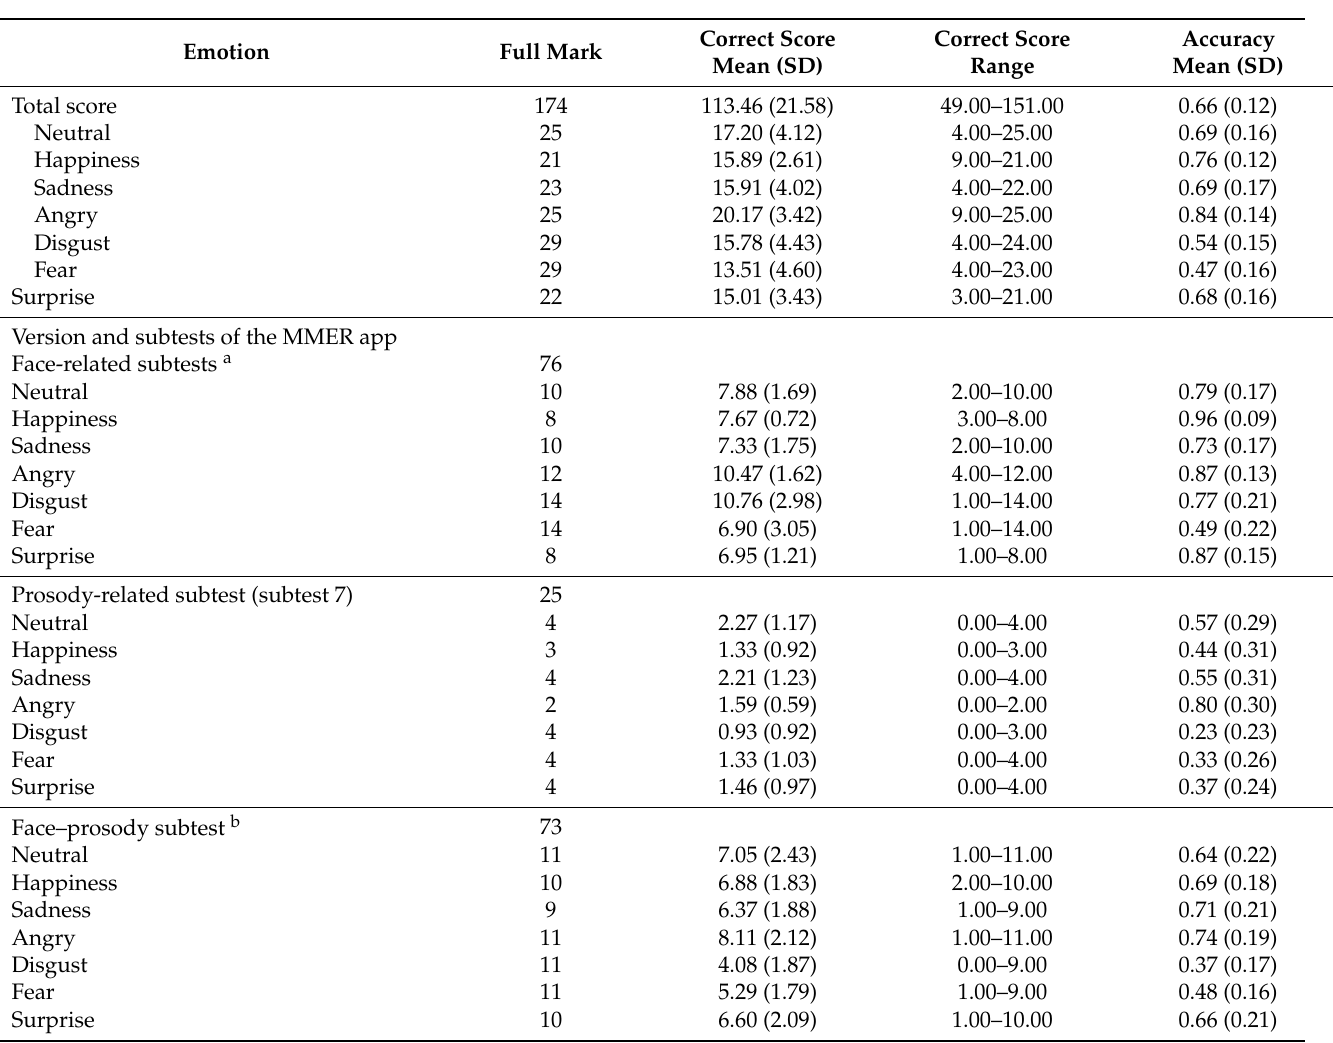
Table 4. Correct score and accuracy of the MMER app in 7 types of